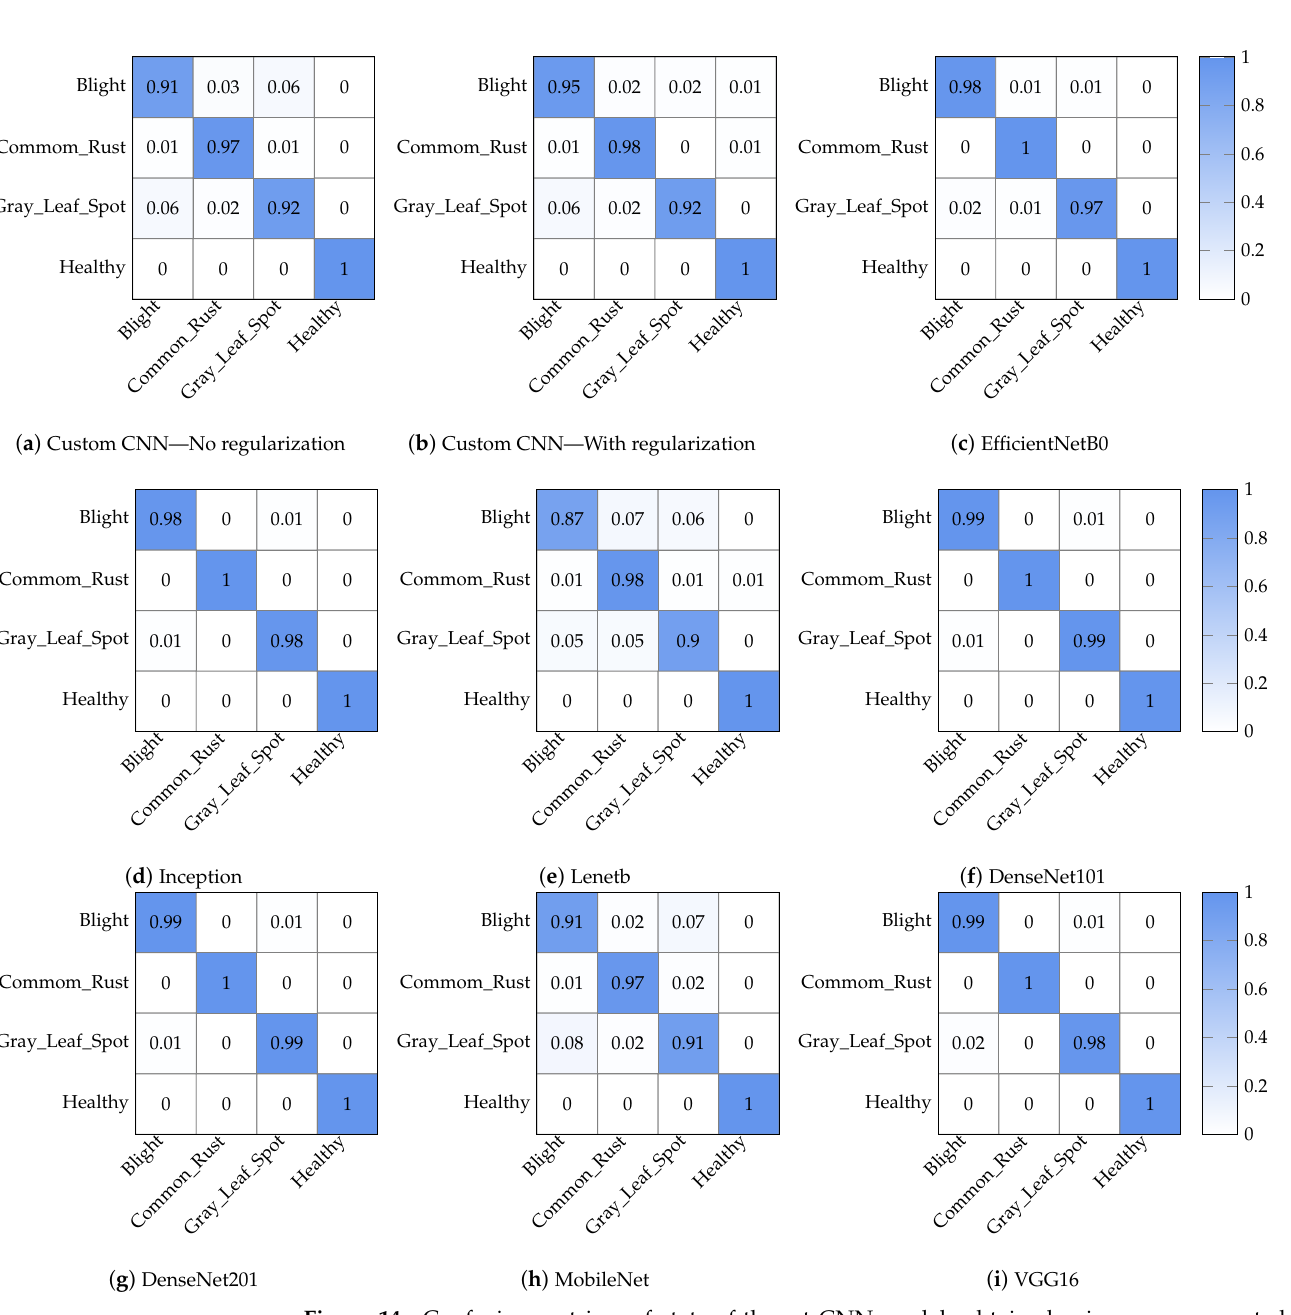
Figure 14. Confusion matrices of state-of-the-art CNN models obtained using our augmented PlantVillage maize leaf disease dataset. Table 3. Comparison of performance of custom CNN on maize leaf disease dataset against state-of- the-art methods (specificity = 2345 and NPV =